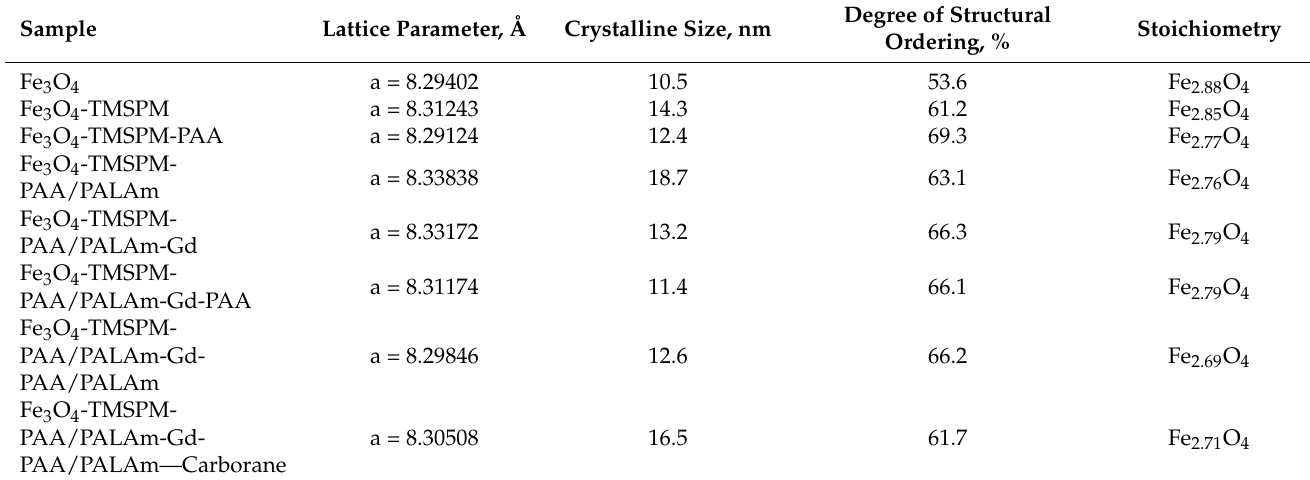
Table 2. Data on structural parameters of XRD analysis.